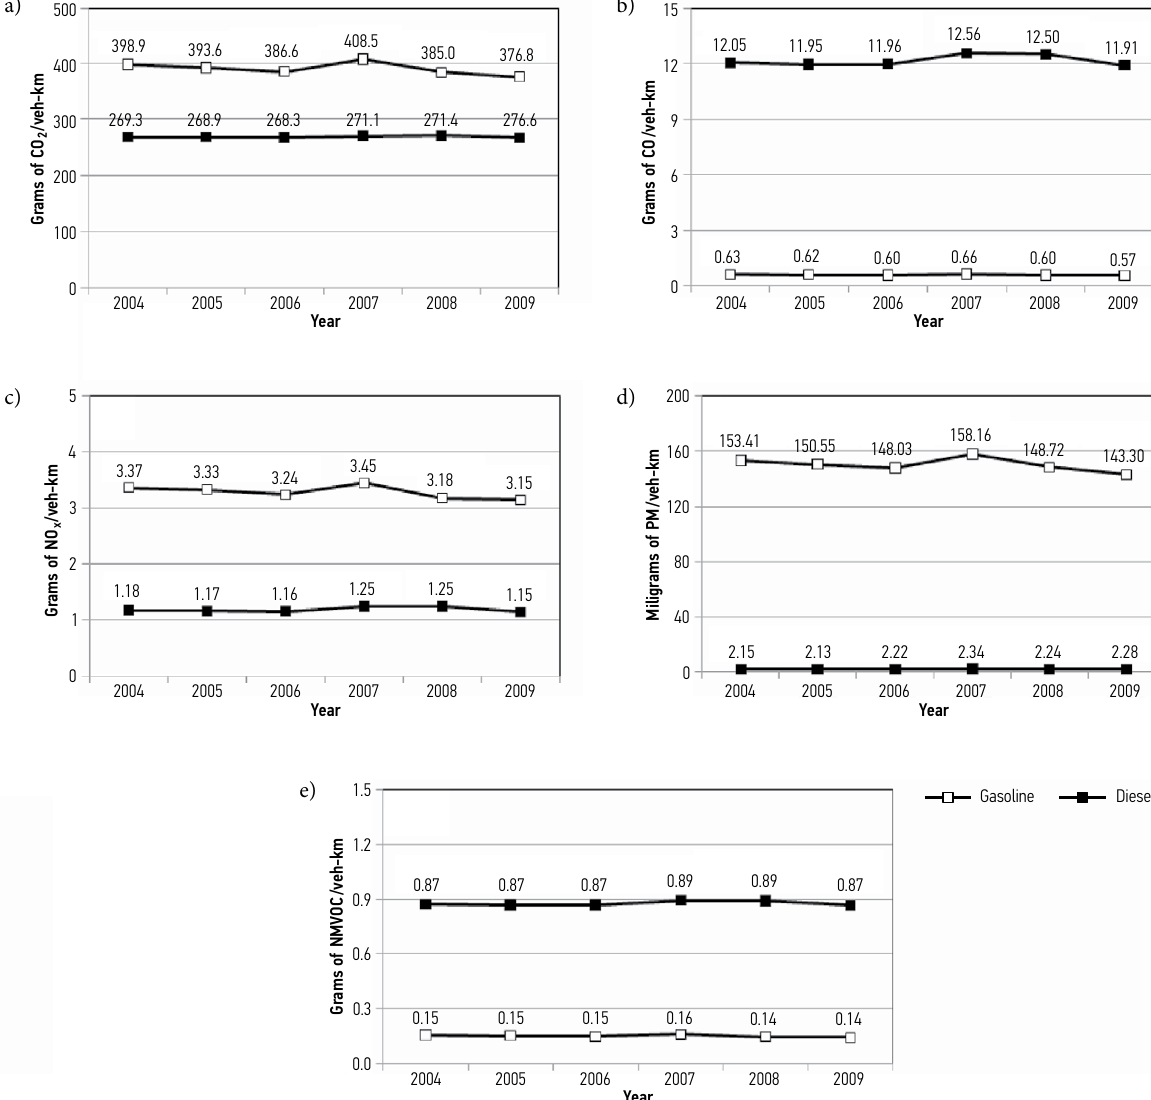
Fig. 6. Estimates of CO 2 and pollutant intensities from the Spanish interurban road transport by fuel type,